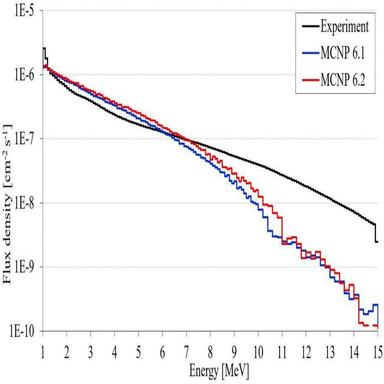
Comparison of calculated and STAYSL evaluated neutron spectra in the central cut in angle 63.43 deg.